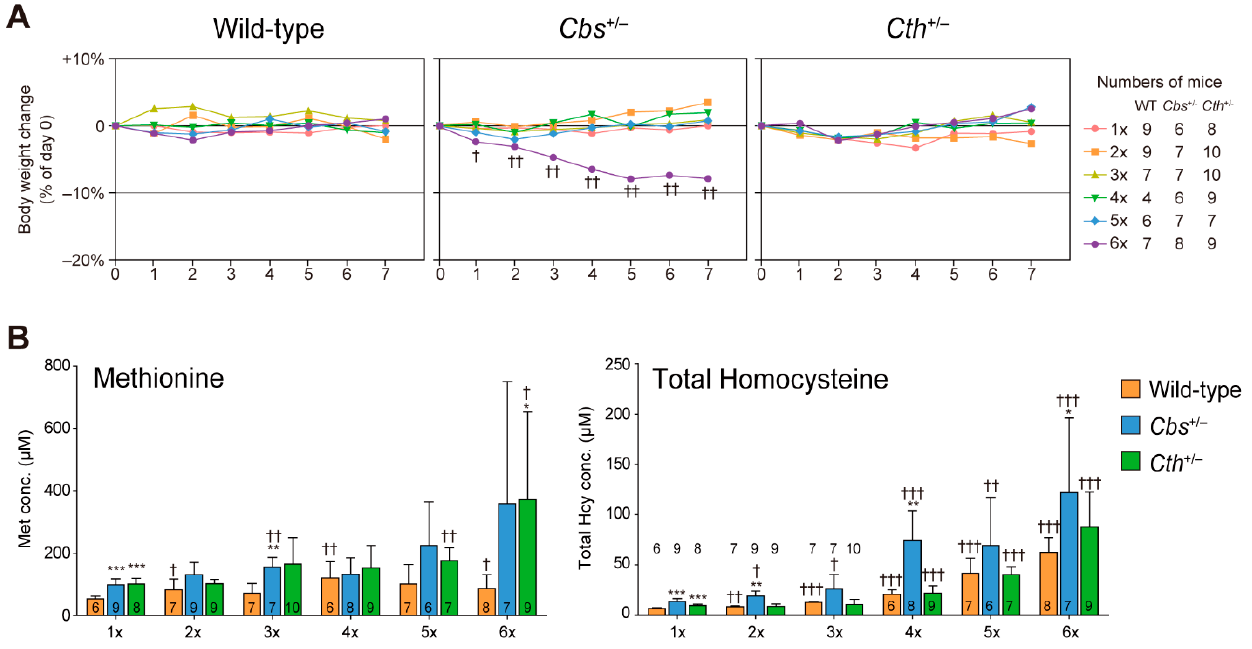
Figure 6. Impact of one-week high-methionine (Met) diet on body weights and serum levels of methionine (Met) and total homocysteine (Hcy) in wild-type and transsulfuration-defective mice. Adult C57BL/6J (wild-type), CBS heterozygous ( Cbs +/ − ), and Cth heterozygous ( Cth +/ − ) male mice were ad libitum fed a standard CE-2 rodent diet (1×Met [0.440%]) until 8–9 weeks of age and then fed 1×Met or CE-2 containing graded concentrations of Met (2×Met [0.880%]–6×Met [2.64%]) for a week. Bodyweight changes ( A ) and serum levels of Met (( B ), left) and total Hcy (( B ), right) are pre- sented. The differences versus their respective 1×Met samples were significant at † p < 0.05, †† p < 0.01, and ††† p < 0.001 and versus wild-type samples at * p < 0.05, ** p < 0.01, and *** p < 0.001 in the Student’s t -test. Numbers of samples (individual mice used) are indicated.